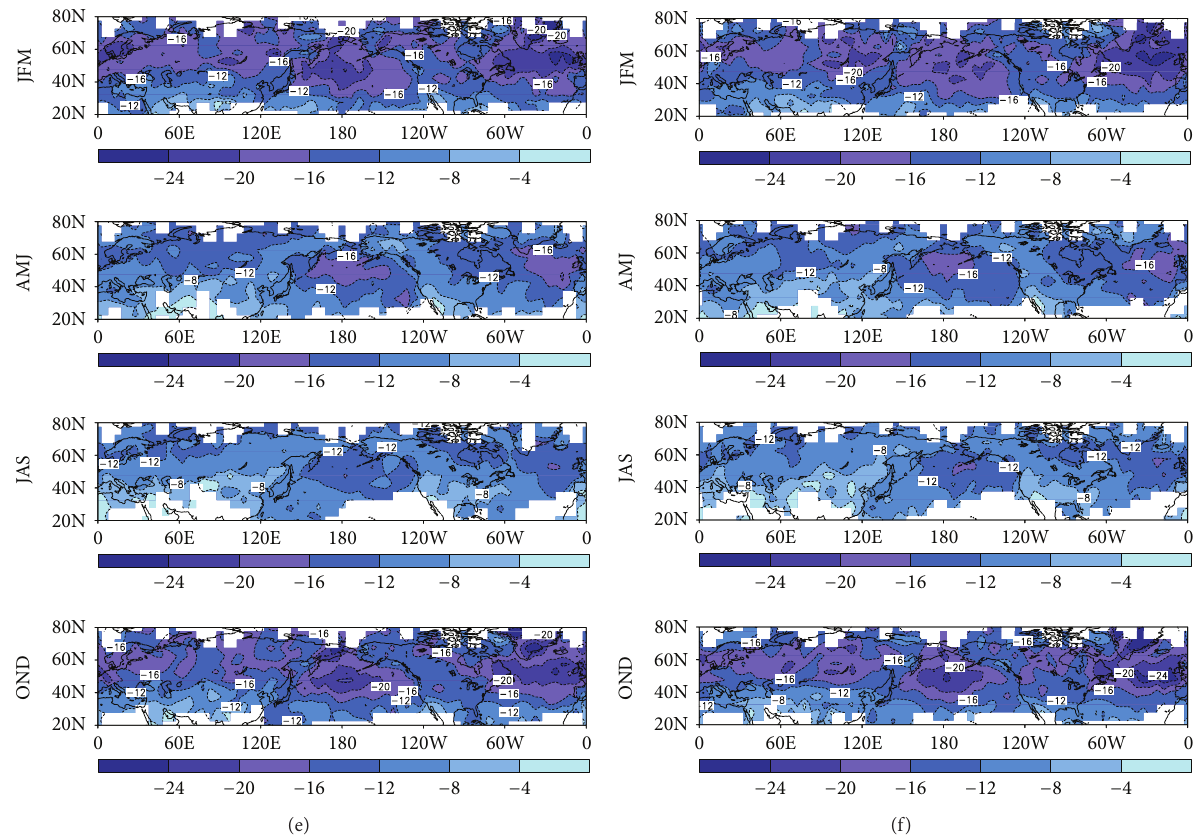
Figure 10: Cyclone track intensity climatology (shaded). Intensity derived by subtracting regressed climatological mean from cyclone track mean (units: hPa) for (a) NCEP1 5010 (JFM, AMJ, JAS, OND), (b) like (a) but for NCEP1 5801, and (c) like (a) but for ERA40 5801. (d) like (a) but for Re27910, (e) like (a) but for NCEP1 7910, and (f) like (a) but for NCEP1